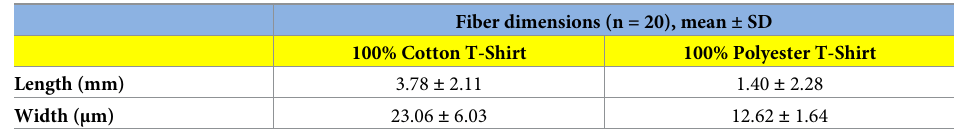
Table 8. Average fiber length and width of fibers collected by tape